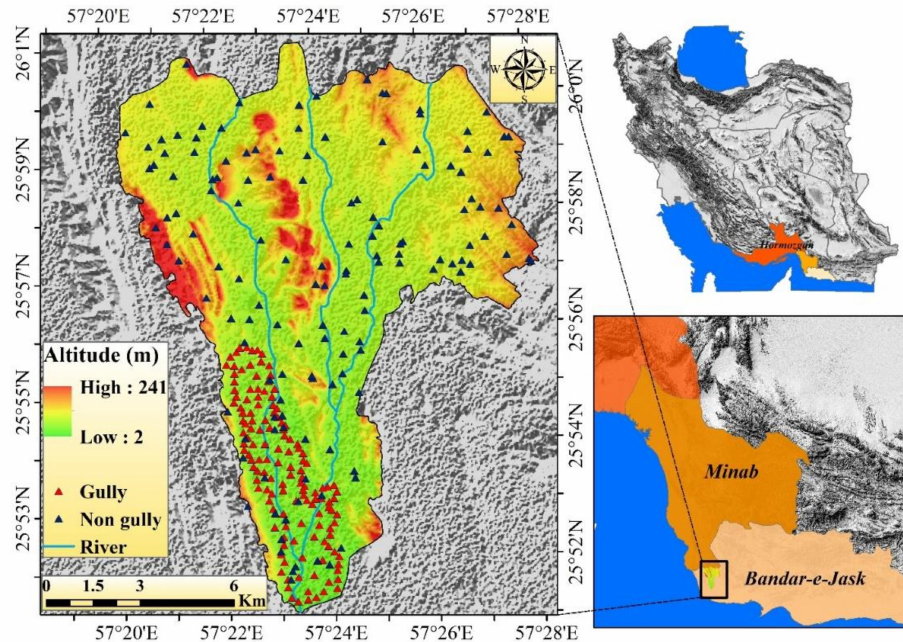
Figure 1. Location of the study area in Iran.